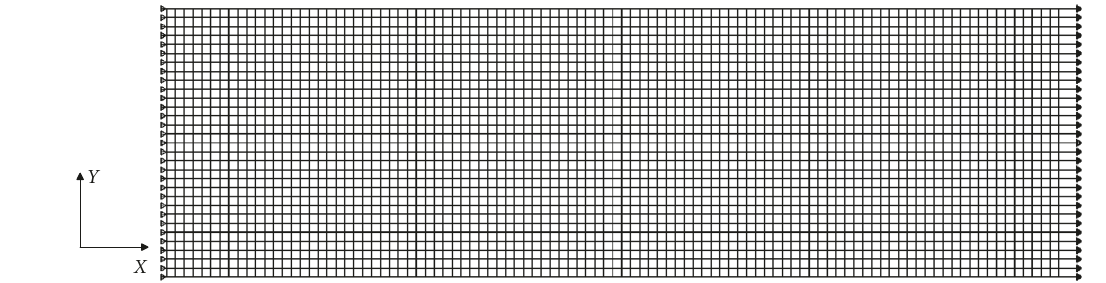
Figure 3: The finite element model of welded joint.